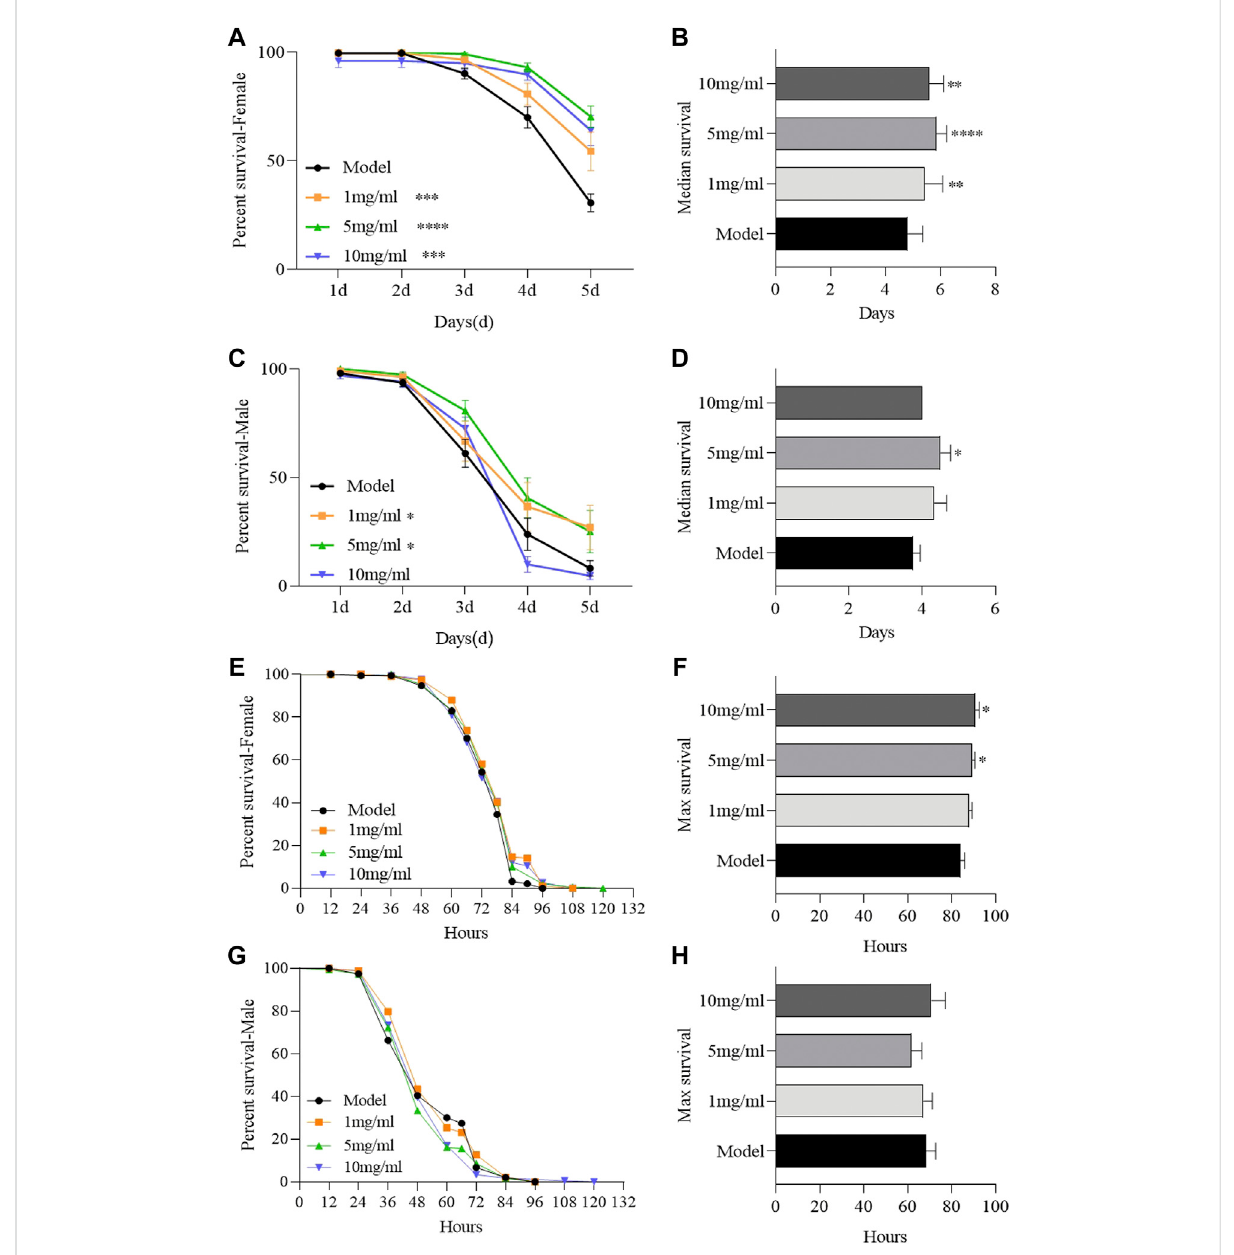
FIGURE 2 FPE amelioratessurvival rates of fl ies during treated with SDS or H 2 O 2 . w 1118 fl ies were reared with standard foods (control group), or with foods supplemented with FPE (1, 5 and 10 mg/ml, respectively). Survivorship curves in different groups of females (A) and males (C) fed the food with 0.6% SDS.Themedianlifespaninfemales (B) andmales (D) fedthefoodwith0.6%SDS.Survivorshipcurvesindifferentgroupsoffemales (E) andmales (G) fed the food with 5% H 2 O 2 . The maximal lifespan in females (F) and males (H) fed the food with 5% H 2 O 2 . Log-rank p values between survival curves are shown. The results are presented as the means ± SEM ( n = 10 – 16). * p < 0 0.05, ** p < 0.01, *** p < 0.001, **** p <